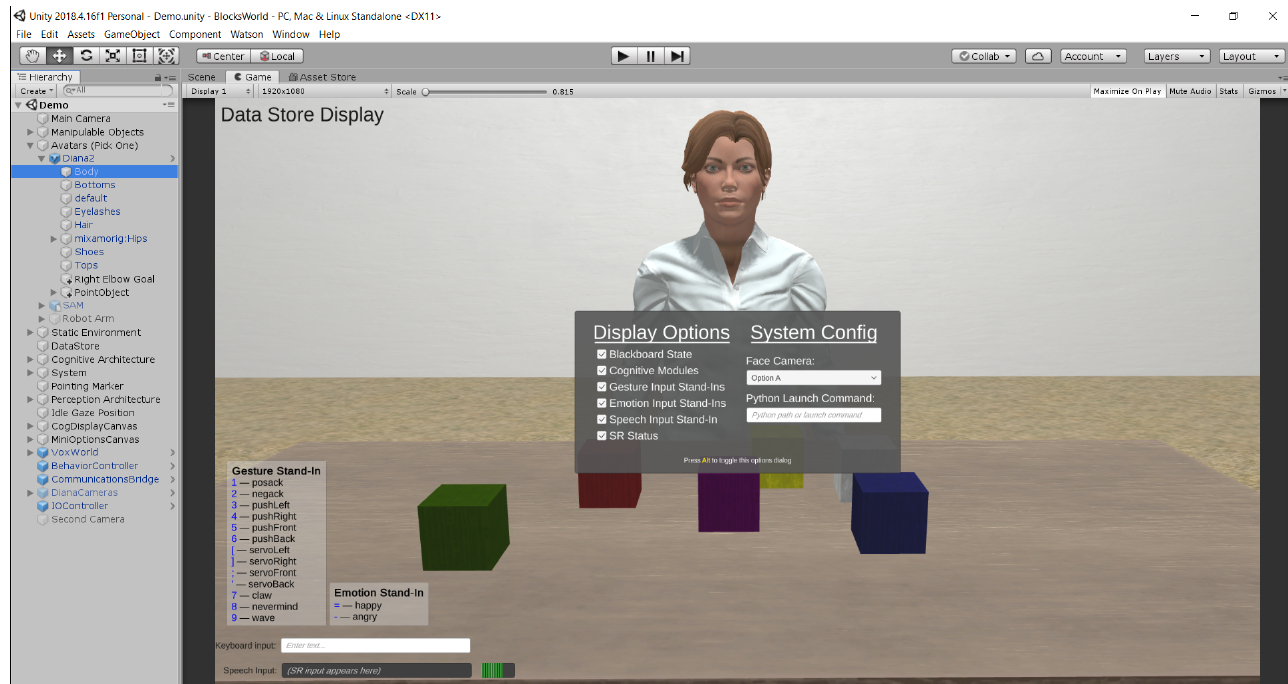
Figure 2. The framework and interface of the Diana